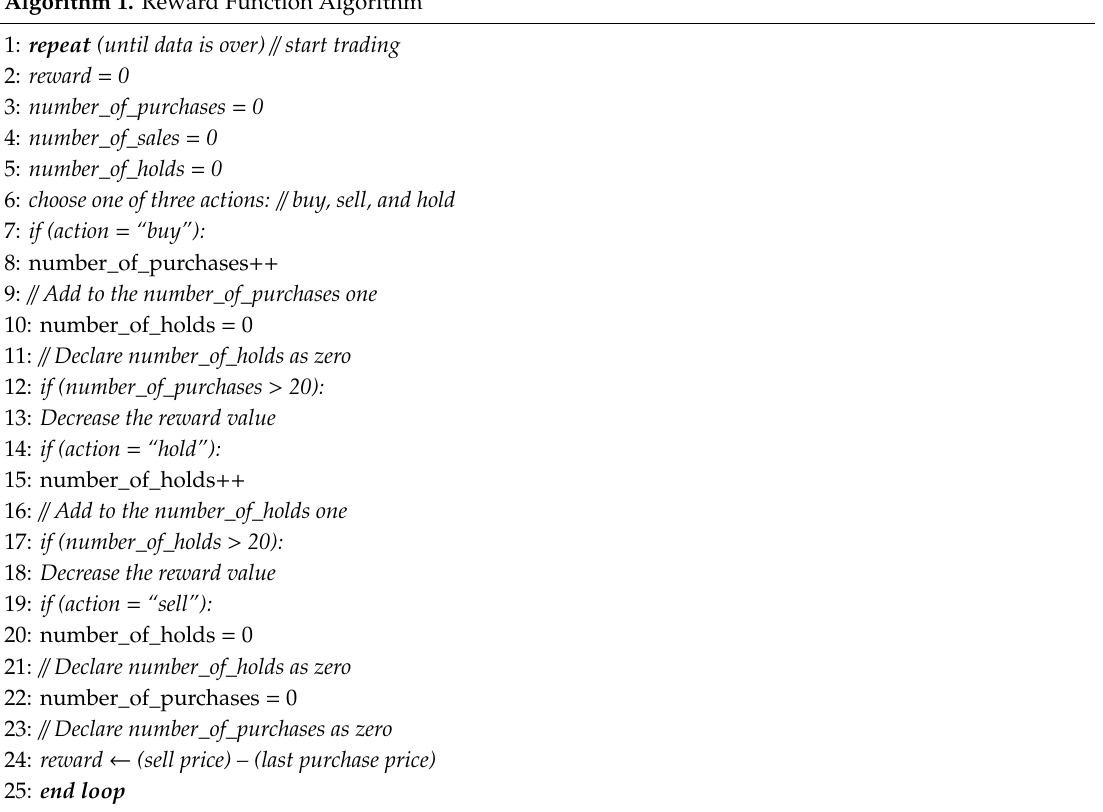
Algorithm 1. Reward Function